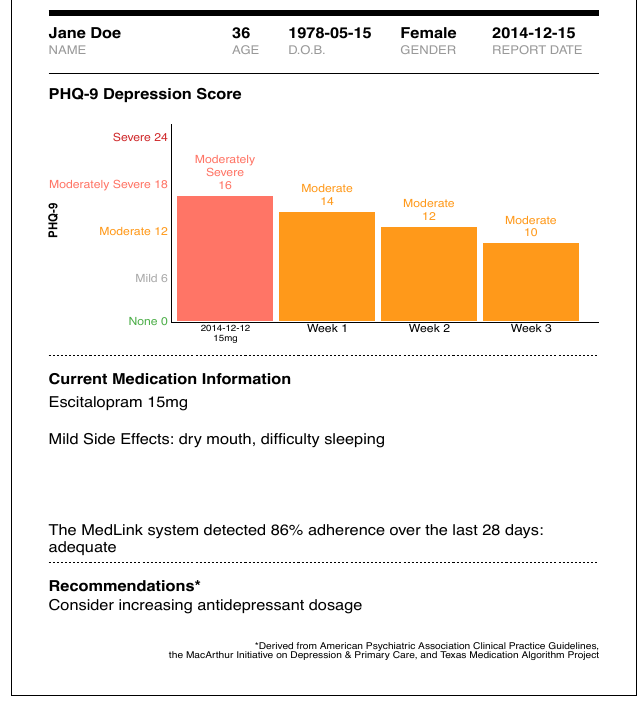
Fig. 3. Physician